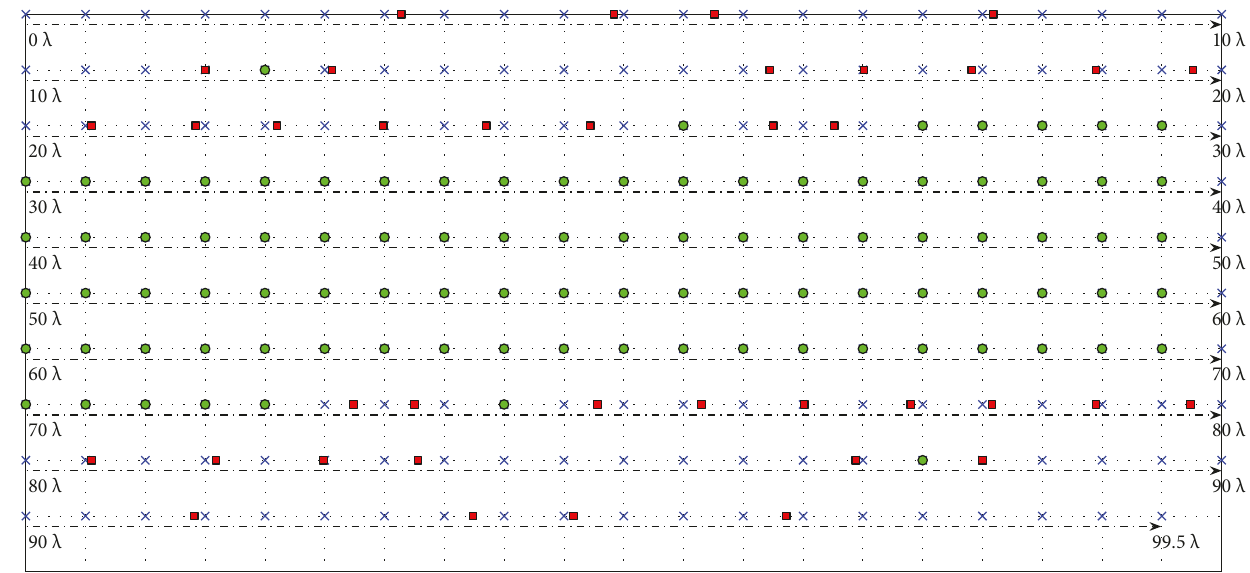
Figure 4: The element locations of the sparse linear array obtained by the IFT-DE based on the TLA described in Figure 3.